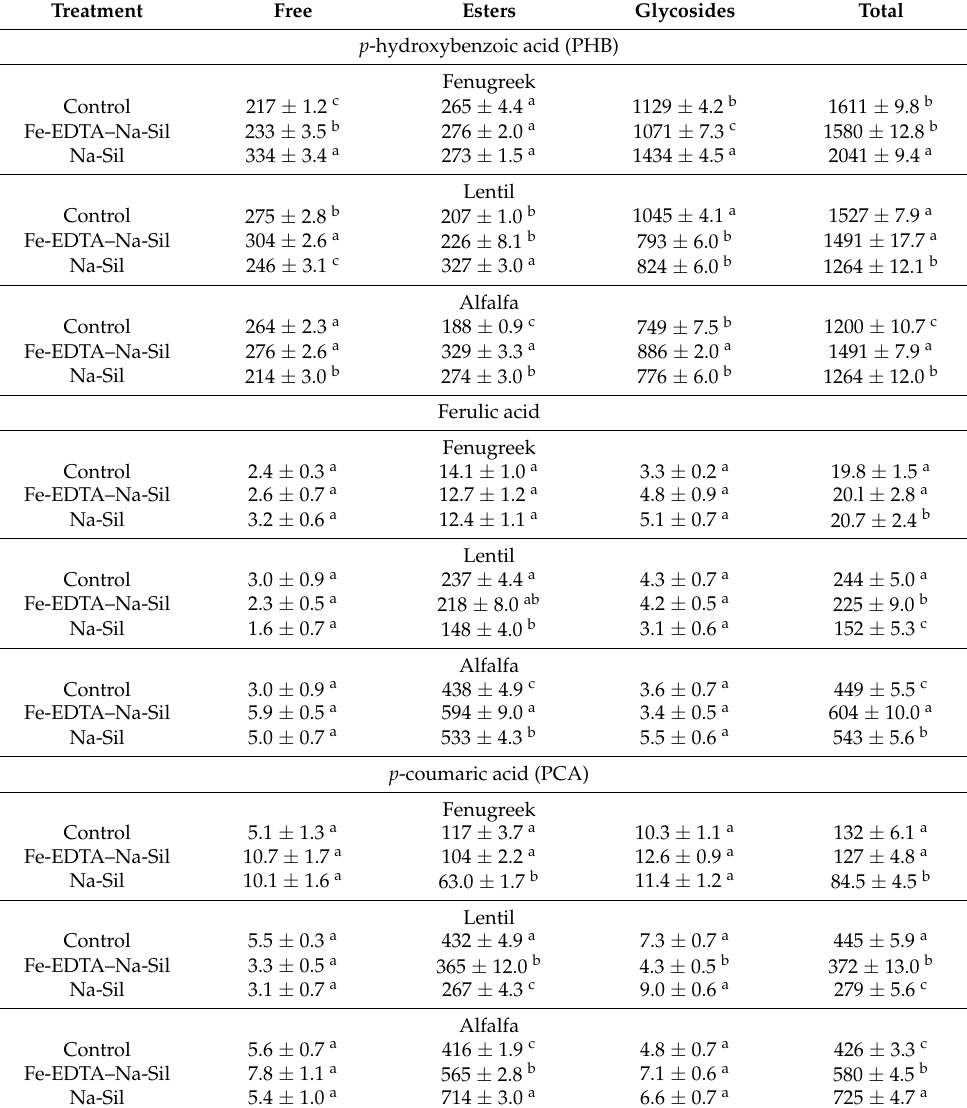
Table 4. The contents of major phenolic acids (free and released from ester and O -glycoside forms) in legume sprouts ( µ g g − 1 DW) treated with elicitors during